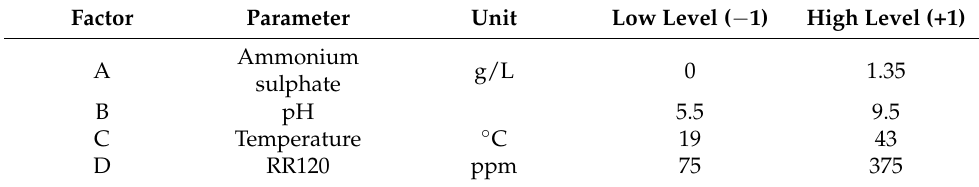
Table 4. Central composite design for tested